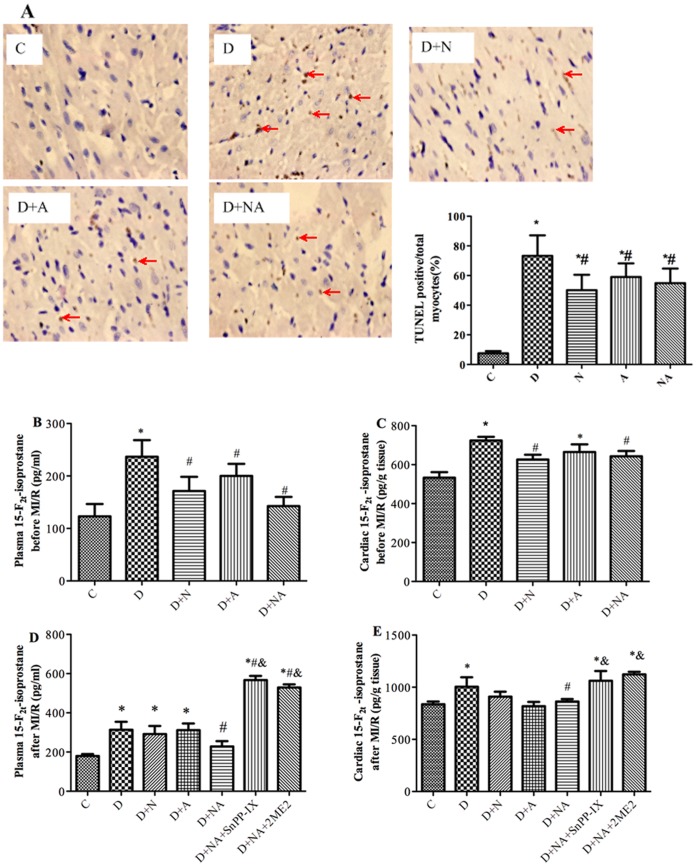
Effects of NAC and ALP on myocardial cell apoptosis assessed by TUNEL staining (A), and on cardiac and plasma 15-F2t-IsoP before and after myocardial ischemia/reperfusion (MI/R) (B–E).TUNEL positive cells were stained brown as indicated by arrow (A). Plasma and cardiac levels of 15-F2t-IsoP were assessed either after the completion of four weeks of NAC and ALP treatment (B, C) or after 30 minutes of ischemia and two hours of reperfusion in control and diabetic rats (D, E). Sham, C and D indicate sham operation, control or diabetes respectively. D+NA, D+ NA+SnPP-IX, D+NA+2ME2 indicate diabetic rats treated with NAC+ALP (NA) or NA +SnPP-IX or NA +2ME2, respectively. Data are expressed as means ±S.E.M. (n = 7). *P<0.05 or P<0.01 vs. C; #P<0.05 vs. D, &P<0.05 vs. D+NA.